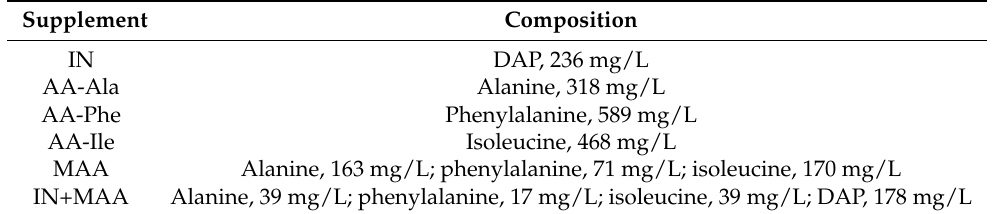
Table 1. Composition of each nitrogen